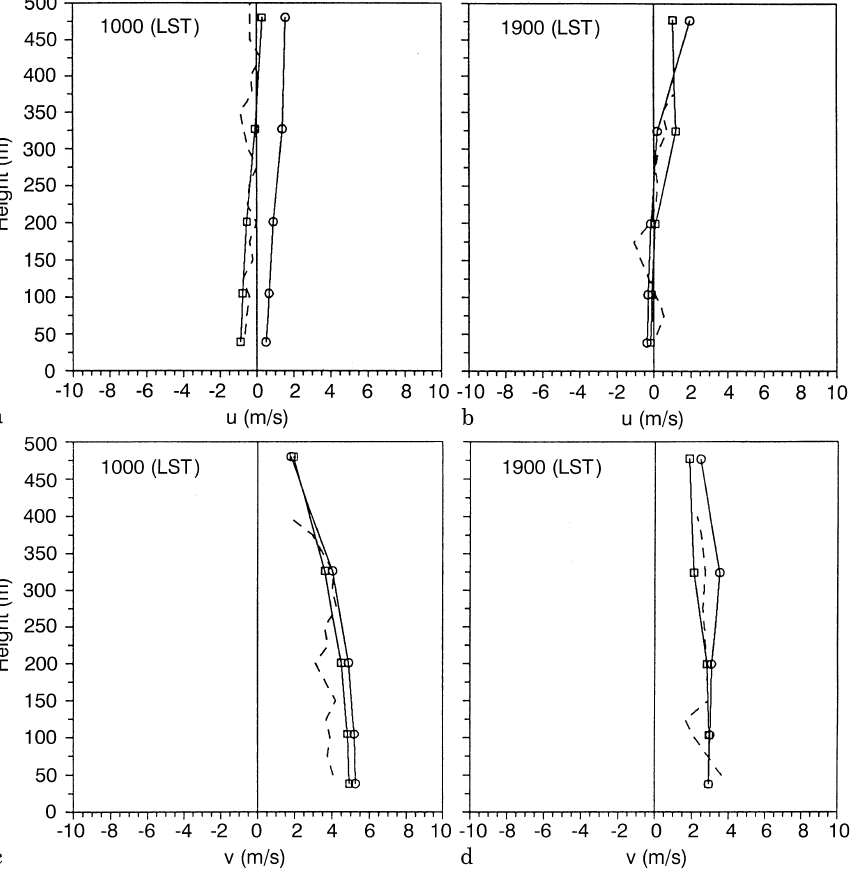
Fig. 8a–d. Vertical profiles of u and v wind velocity components, at the sodar location. a 1000 LST, u ; b 1900 LST, u ; c 1000 LST, v ; d 1900 LST, v . Squares and circles show results obtained for the E1 and E2 cases, respectively. The dashed line is the sodar